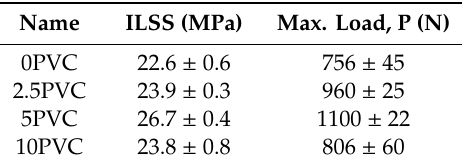
Table 4. ILSS of